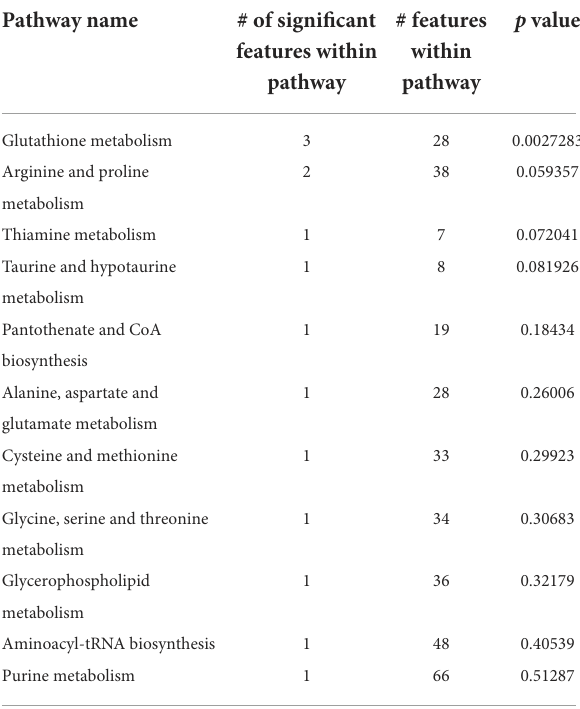
TABLE 2 Network activity prediction analysis of the metabolic pathways. Network activity prediction